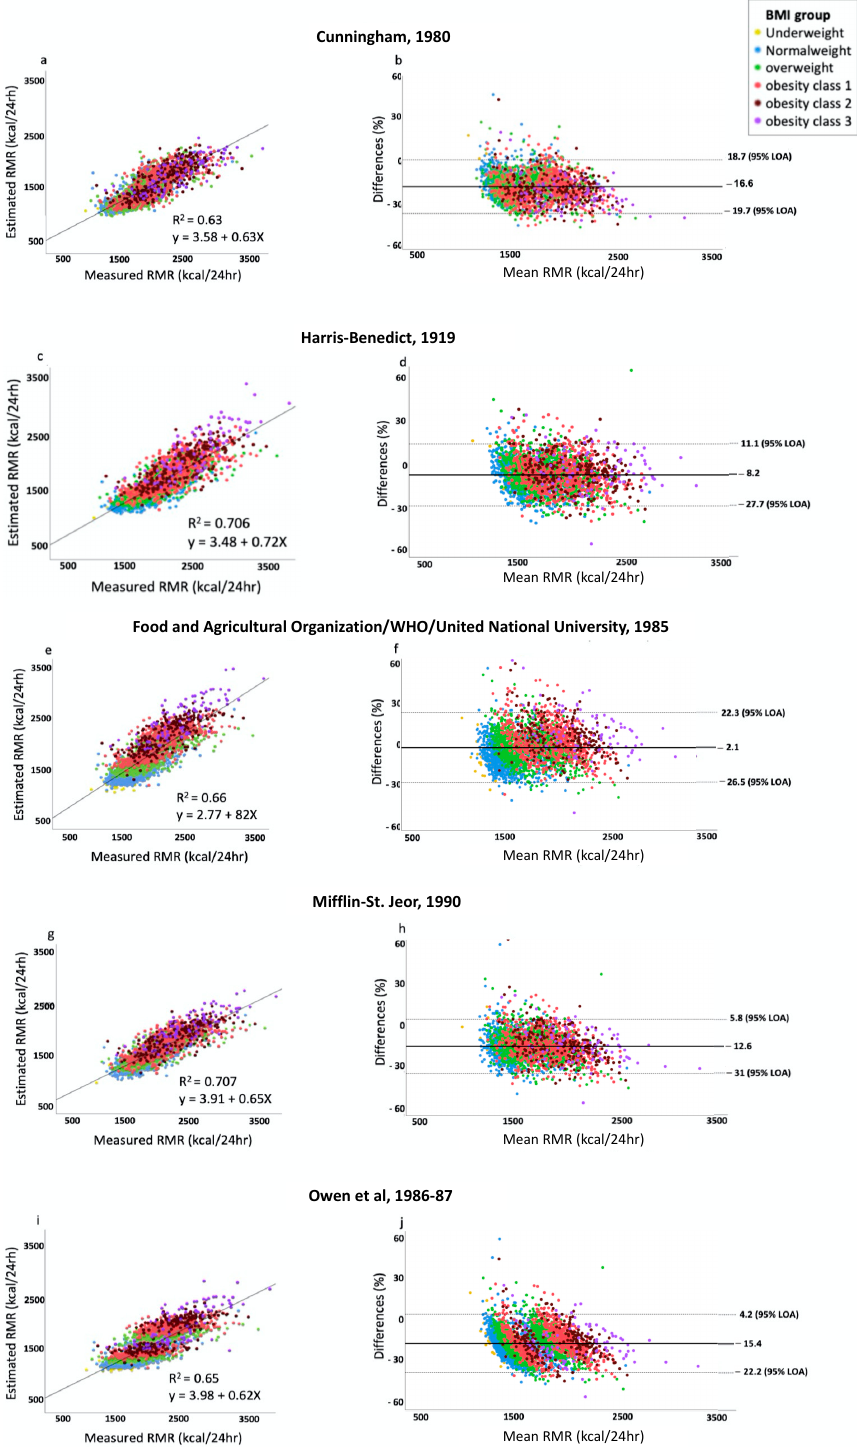
Figure 2. Bland–Altman analysis presenting the bias and the 95% level of agreement between each prediction equation and the measured RMR. The x-axis represents the mean of the measured and estimated RMR, and the y-axis expresses the difference in percentage between the RMR predicted using each of the equations and the RMR measured as follows: (pRMR-mRMR/mRMR)/100). Lin’s concordance correlation was used to determine the R 2 and the linear equation between each common equation and the measured RMR. ( a , b ) Cunningham [20,22]; ( c , d ) Harris–Benedict [3]; ( e , f ) Food and Agricultural Organization/WHO/United National University [4]; ( g , h ) Mifflin–St. Jeor [5]; ( i , j ) Owen et al. equations